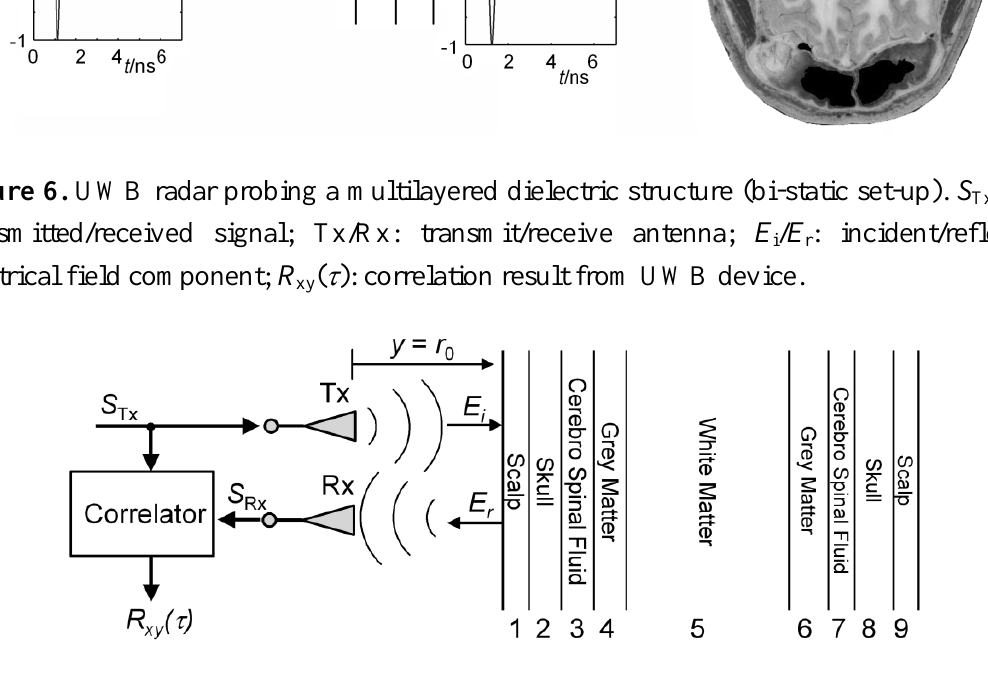
Figure 6. UWB radar probing a multilayered dielectric structure (bi-static set-up). S